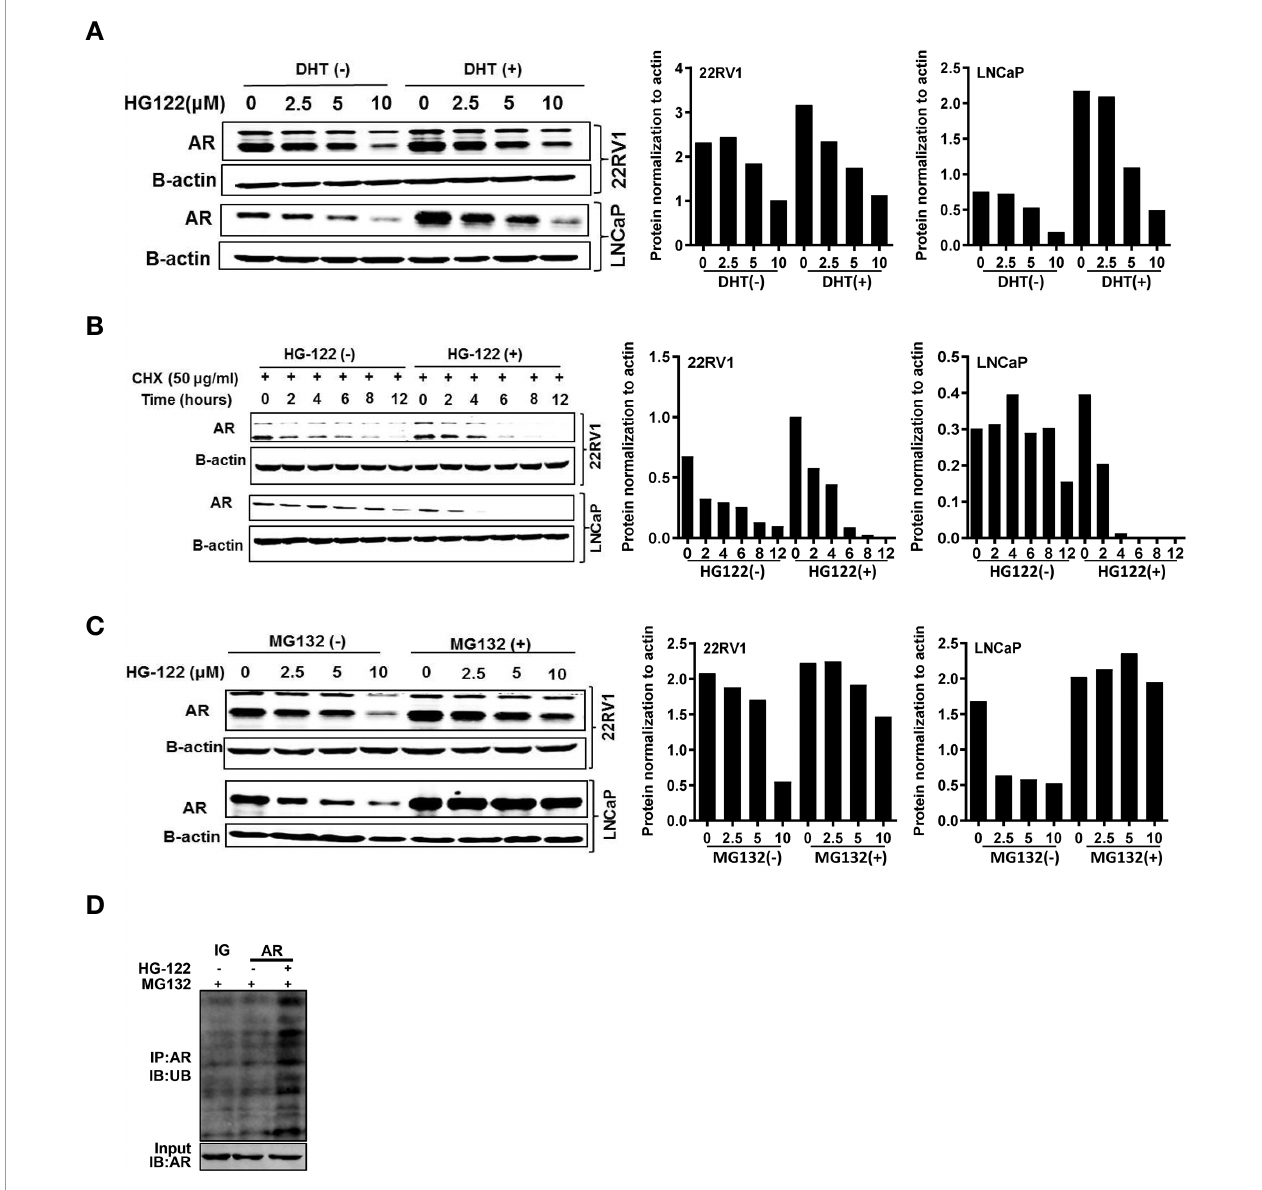
FIGURE 4 | HG122 degraded AR protein. (A) HG122 down-regulated AR protein. LNCaP and 22RV1 cells were treated for 12 h with indicated concentrations of HG122 with or without DHT, and the AR protein level was measured using western blotting. (B) AR protein half-life was shortened by HG122. LNCaP and 22RV1 cells were treated with cycloheximide with or without HG122 for various periods. The AR protein level was measured using western blotting. (C) The HG122-induced decrease in AR protein was rescued by the proteasome inhibitor MG132. LNCaP and 22RV1 cells were treated with various concentrations of HG122 with or without 10 m M MG132, and the AR protein level was measured using western blotting. (D) HG122 induces ubiquitination of AR. LNCaP cells were treated with or without HG122 in the presence of MG132. Immunoprecipitation (IP) was done using anti-AR and immunoblotting was done with anti-ubiquitin